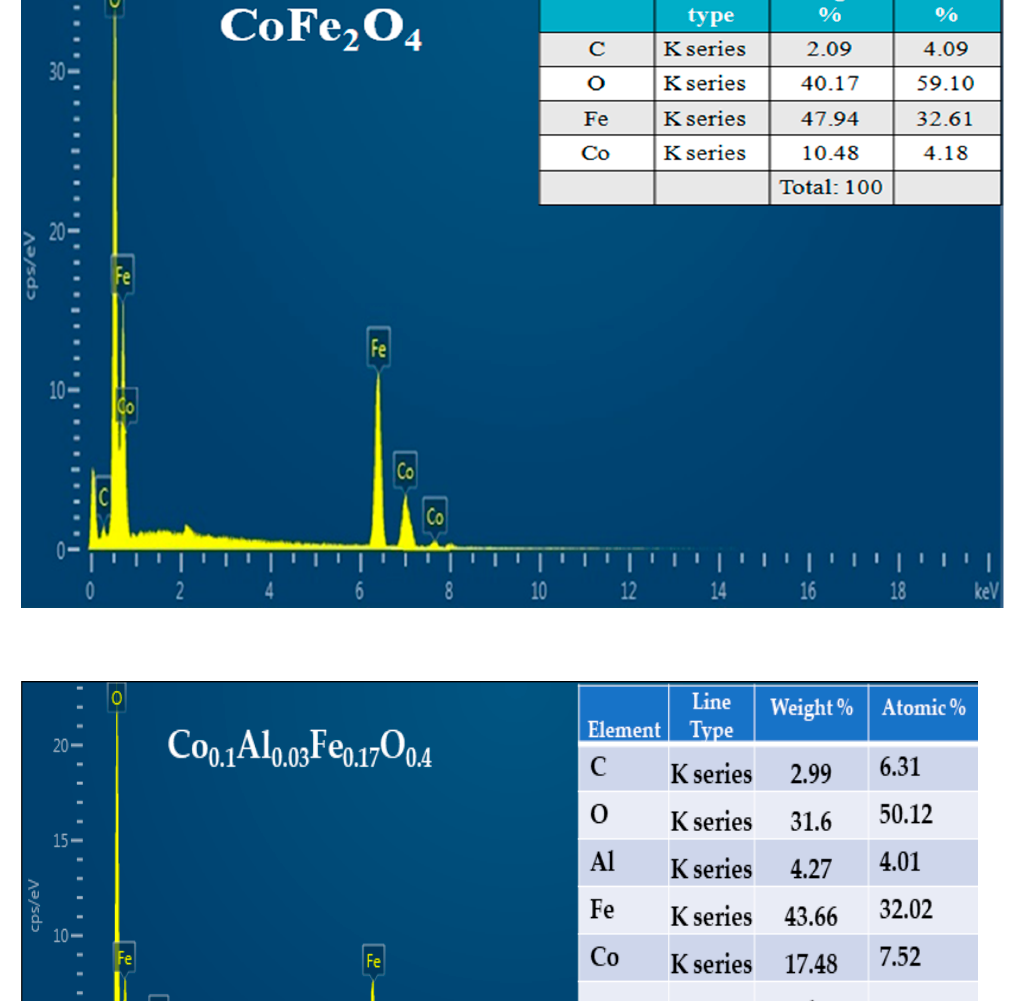
Figure 8 is representative of the EDS spectra showing the presence of Co, Al, Fe, and oxygen. Water 2020 , 12 , x FOR PEER REVIEW